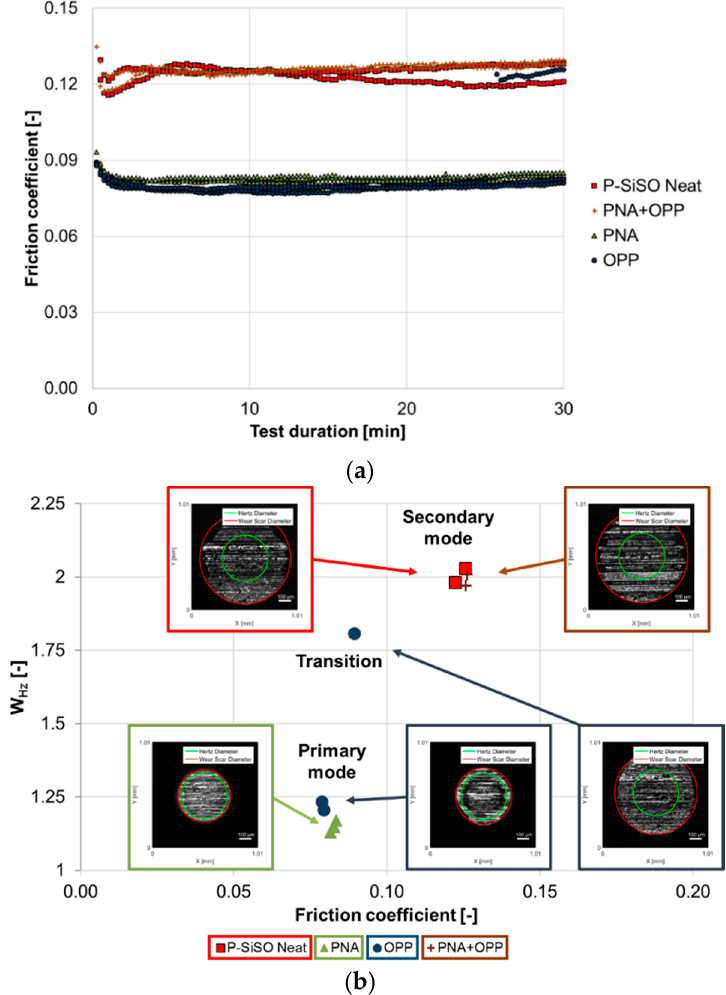
Figure 9. Results from the experiments at C{300 N/80 °C/30 min}. ( a ) Friction traces of Neat P-SiSO compared to P-SiSO with additives N -Phenyl-1-naphthylamine (PNA), Ortho -phenylene phosphate (OPP), and PNA + OPP. ( b ) Corresponding µ-W chart with insets of ball wear scars. SEM images and EDS spectra of the wear track lubricated with P-SiSO + PNA added is shown in Figure 10. EDS analysis was performed on spots both in the center region and at the edge of the wear scar. In the center region of this effective boundary film, the composition was rich in the elements